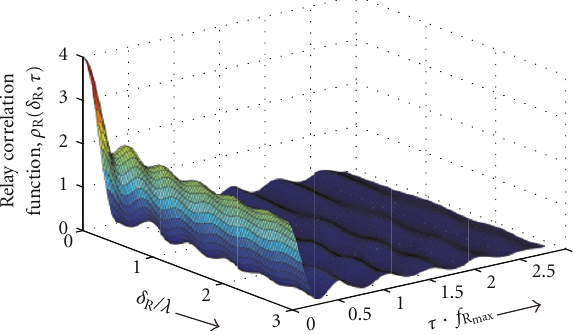
Figure 4: The source CF (cid:22) ρ S ( δ S , τ ) of the 2 × 2 × 2 MIMO M2M stochastic channel simulator under isotropic scattering conditions.